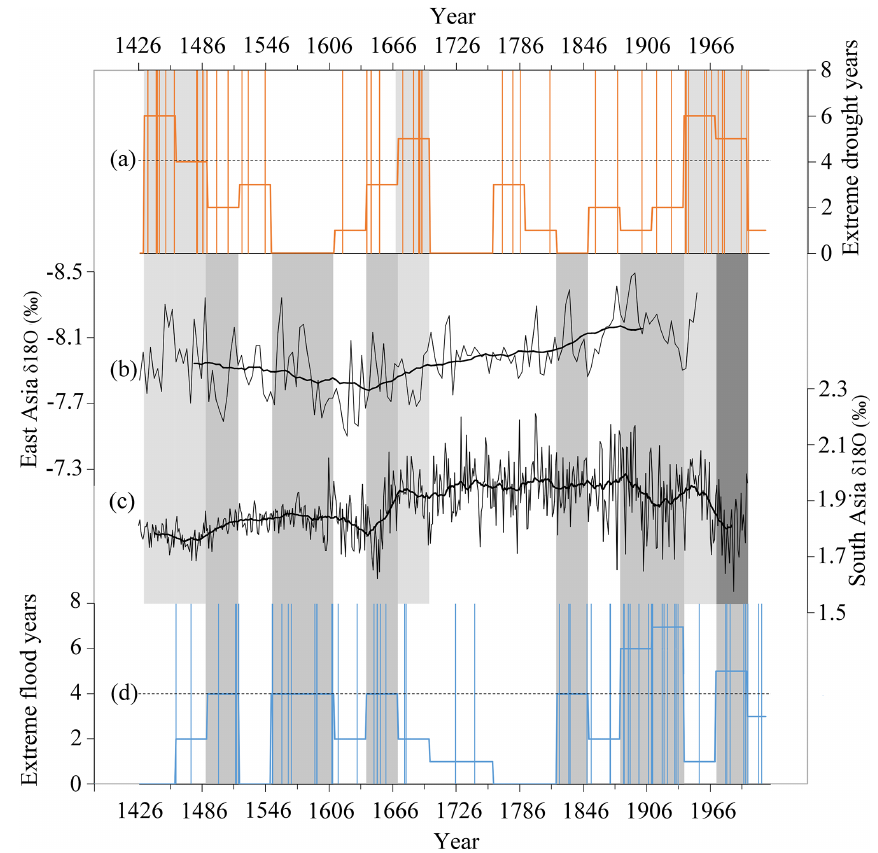
Figure 10. Comparison of the HRB extreme drought and flood years with the East Asian summer monsoon index and South Asian summer monsoon index as indicated by δ 18 O records (‰). The light grey areas represent periods of high frequency of extreme drought, the medium grey areas represent periods of high frequency of extreme floods, and the dark grey areas represent periods of high co-occurrence of extreme droughts and floods. (a) Extreme drought years. The vertical line shows the individual extreme drought years, and the ladder is the number of extreme drought years every 30 years. (b) East Asian summer monsoon index, 1426–1949 (P. Zhang et al., 2008a). The thick black line indicates the 30-year sliding average. (c) South Asian summer monsoon index, 1426–2000 (Shi et al., 2014a). The thick black line indicates the 30-year sliding average. (d) Extreme flood years. The vertical line shows the individual extreme flood years, and the ladder is the number of extreme flood years every 30